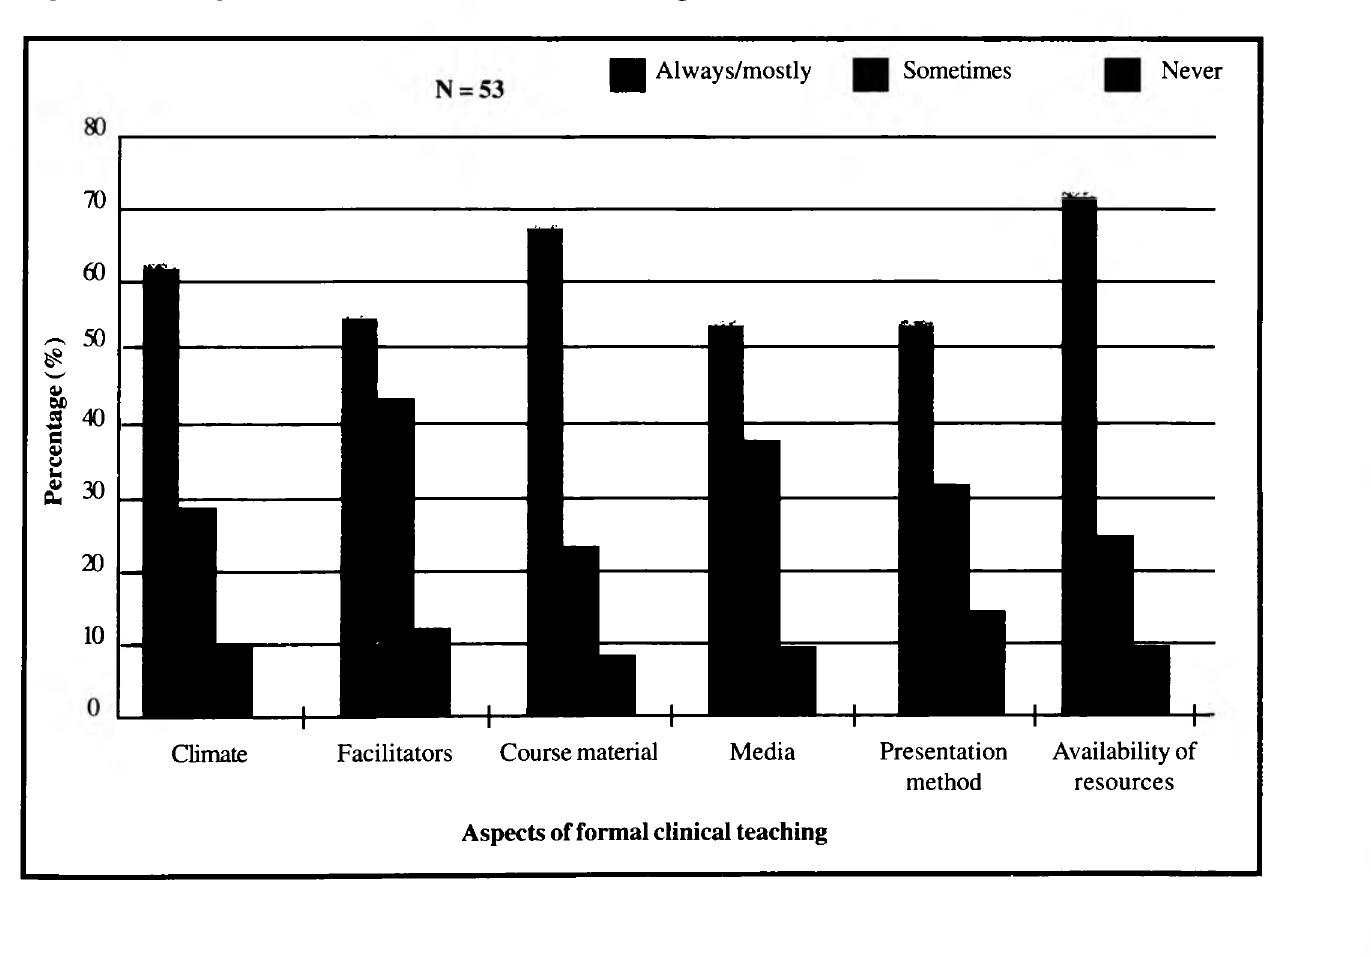
Figure 1: Response rate in formal clinical teaching in simulation laboratories ■ Always/mostly Sometimes